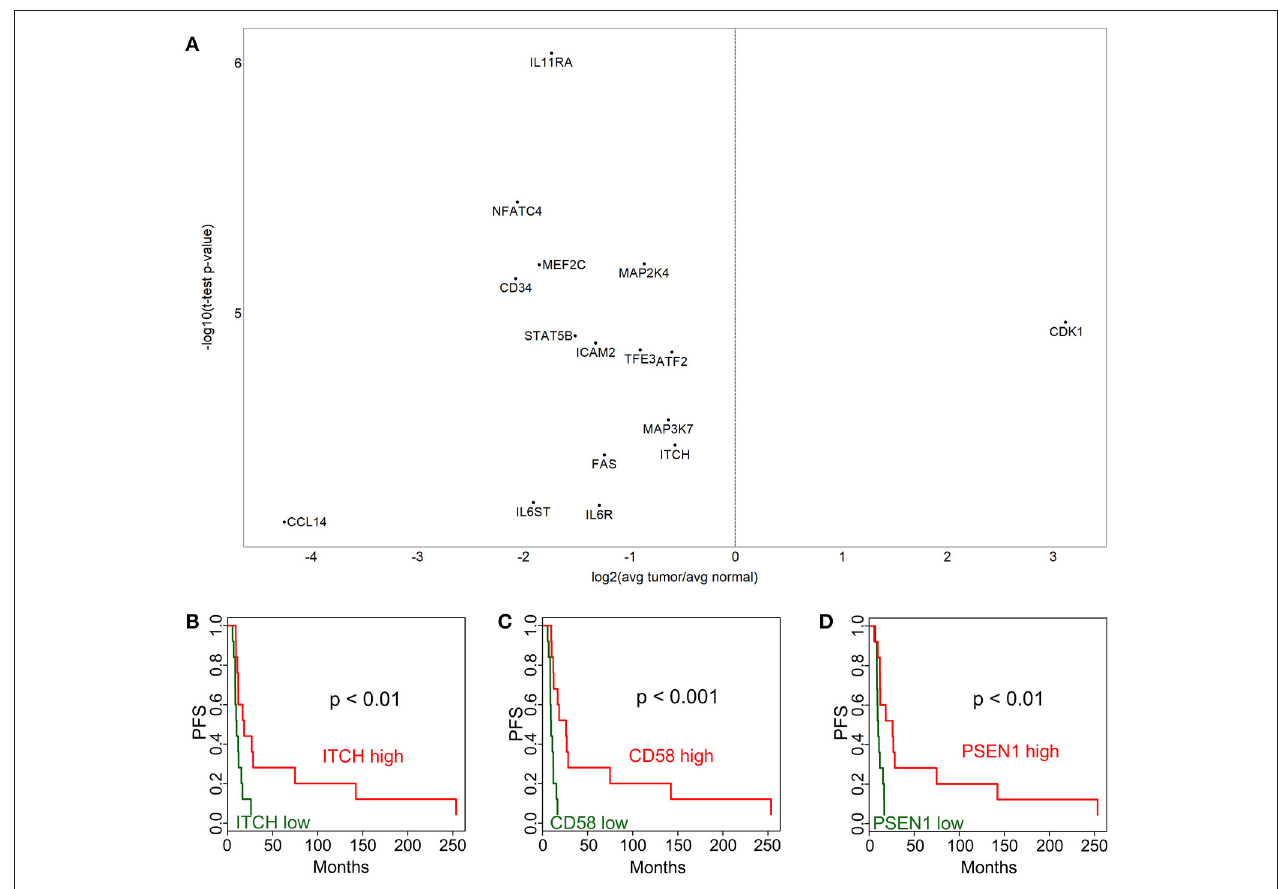
FIGURE 1 | Immune-related gene expression alterations in cervical cancer. Over- and under-expressed immune-related genes in cervix tumors compared to adjacent normal tissue are shown in (A) . Association between progression-free survival (PFS) and gene expression is displayed for ITCH (B) , CD58 (C) , and PSEN1 (D) . High expression (above median) is depicted with red color, while low expression (below median) is green.